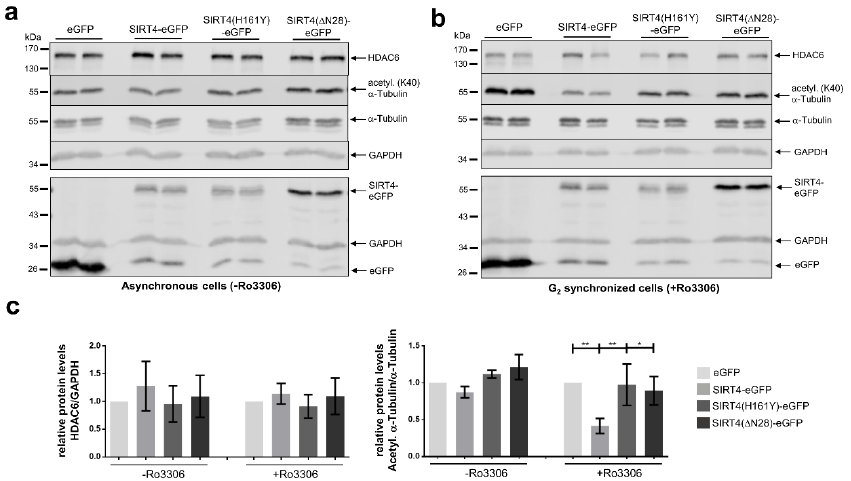
Figure 7. Ectopic expression of SIRT4 impacts negatively on acetylated α -tubulin (K40) during mitosis. HEK293 cells stably expressing eGFP, SIRT4-eGFP, or mutants thereof were either asynchronously grown ( a ) or subjected to Ro3306-mediated G 2 synchronization ( b ) followed by immunoblot analysis of HDAC6, acetylated α -tubulin (K40), and α -tubulin. Expression of eGFP, SIRT4-eGFP, or mutants thereof was analyzed in a second immunoblot (lower panels in a and b ). Probing against GAPDH was employed as loading control. Relative HDAC6 amounts and acetylated α -tubulin (K40) / α -tubulin levels were quantified by densitometric analysis ( c ). To evaluate statistical significance one-way ANOVA followed-up by Tukey’s test was performed (three independent experiments; * p < 0.05; ** p < 0.01). All P-values of the analysis of acetylated α -tubulin (K40) / α -tubulin levels ( + Ro3306) refer to comparison with